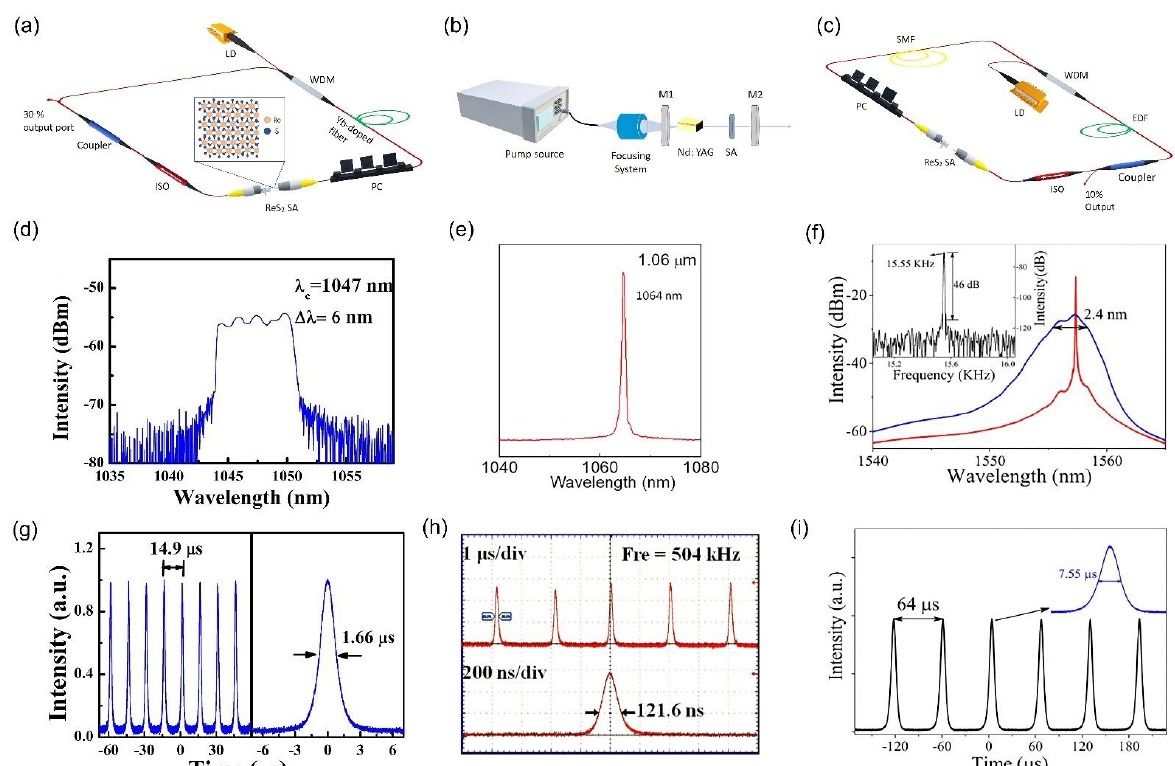
Figure 15. Q-switched pulsed lasers with ReS 2 SA. ( a , c ) cavity designs; ( d , f ) output spectrum; ( g , i ) output pulse trains and the corresponding pulse profile along with the repetition rate and pulse duration. ( a ) Adapted with permission from ref. [ 126 ] . Copyright 2018 IEEE. ( b ) Adapted with permission from ref. [ 69 ] . Copyright 2019 John Wiley and Sons. ( c ) Adapted with permission from ref. [ 63 ] . Copyright 2018 IEEE. ( d , g ), Reprinted with permission from ref. [ 126 ] . Copyright 2018 IEEE. ( e , h ), Reprinted with permission from ref. [ 69 ] . Copyright 2019 John Wiley and Sons. ( f , i ), Reprinted with permission from ref. [ 63 ] . Copyright 2018 IEEE.